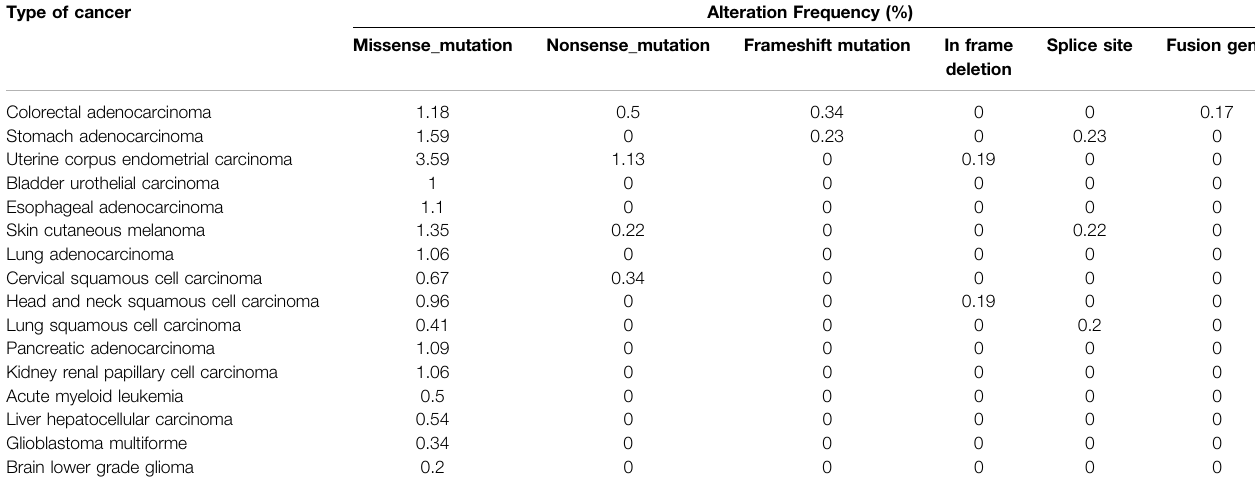
TABLE 2 | Mutations of SRSF6 gene in cancers according to cBioPortal online TCGA cancer database. Type of cancer Alteration Frequency